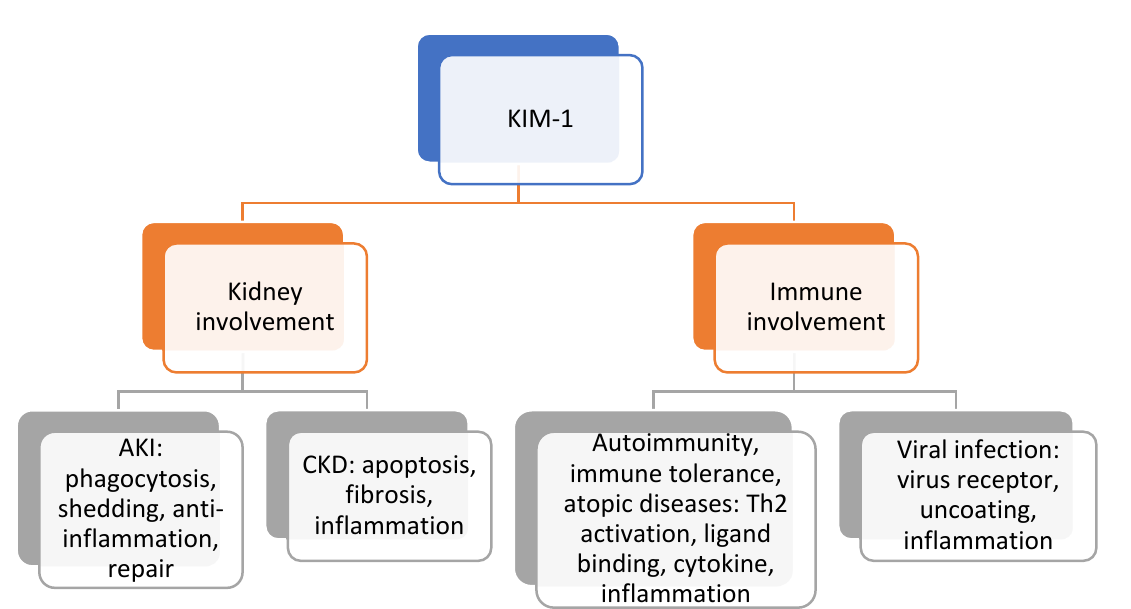
Figure 1. The role of KIM-1 in different diseases with underlying pathophysiologic processes. KIM- 1—kidney injury molecule 1, AKI—acute kidney injury, CKD—chronic kidney disease.